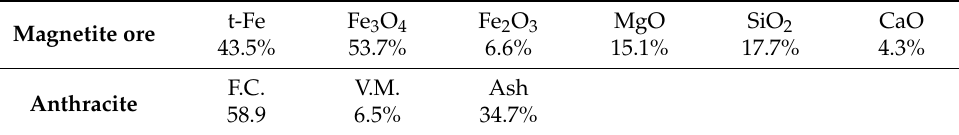
Table 1. Compositions of iron ore and coal used in the present study. t-Fe Magnetite ore